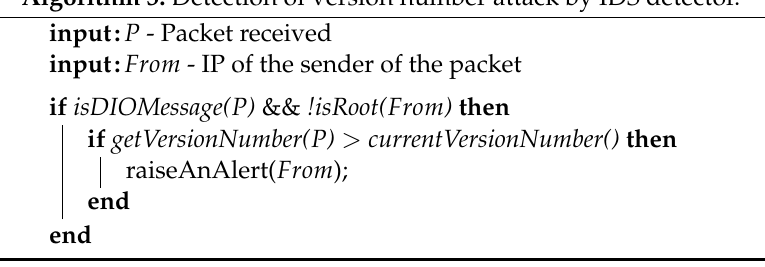
Algorithm 3: Detection of version number attack by IDS detector.